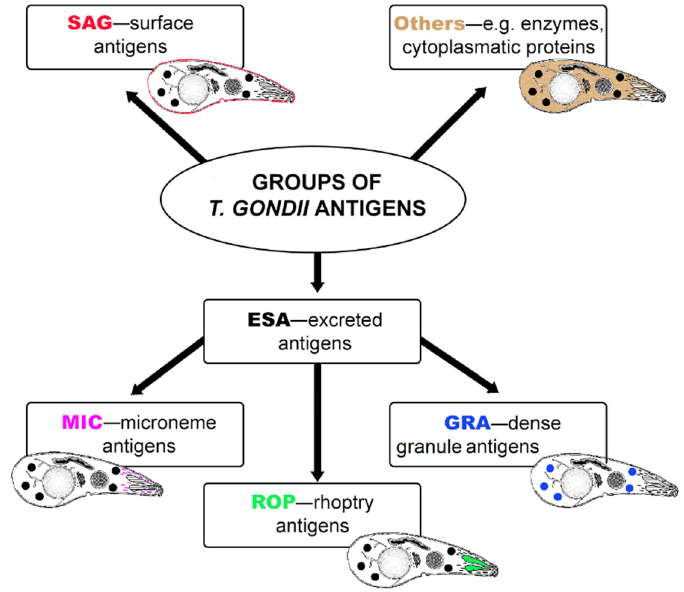
Figure 1. The main groups of T. gondii antigens. Table 1. Recombinant T. gondii antigens tested in the IgG avidity